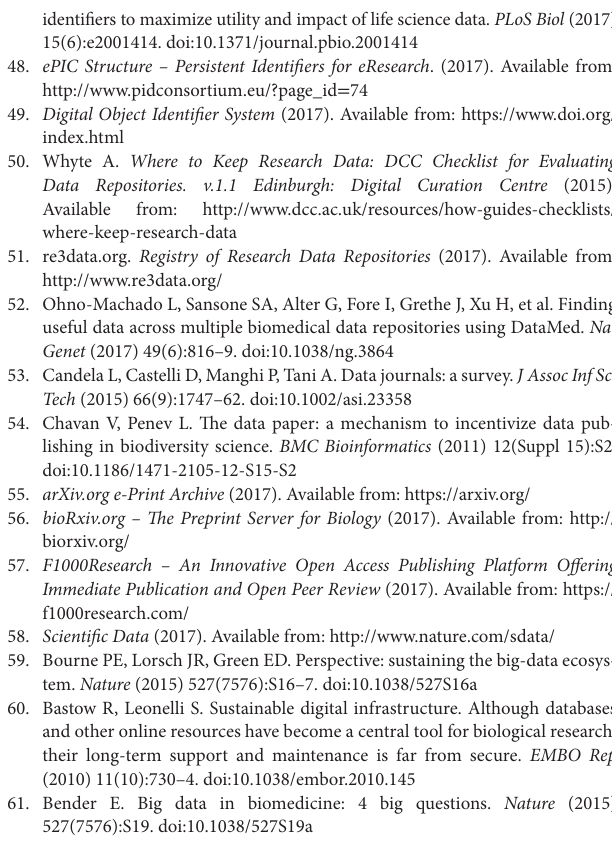
Figueiredo Features and Guidelines for Sharing